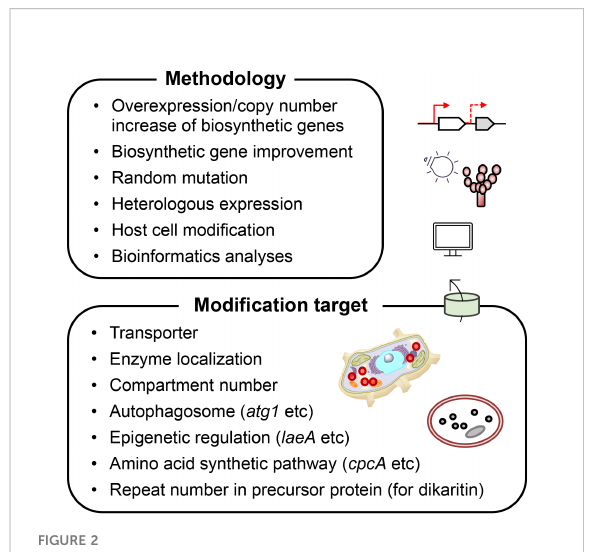
FIGURE 2 Summary of approaches to improve the production of NRPs and RiPPs in fi lamentous